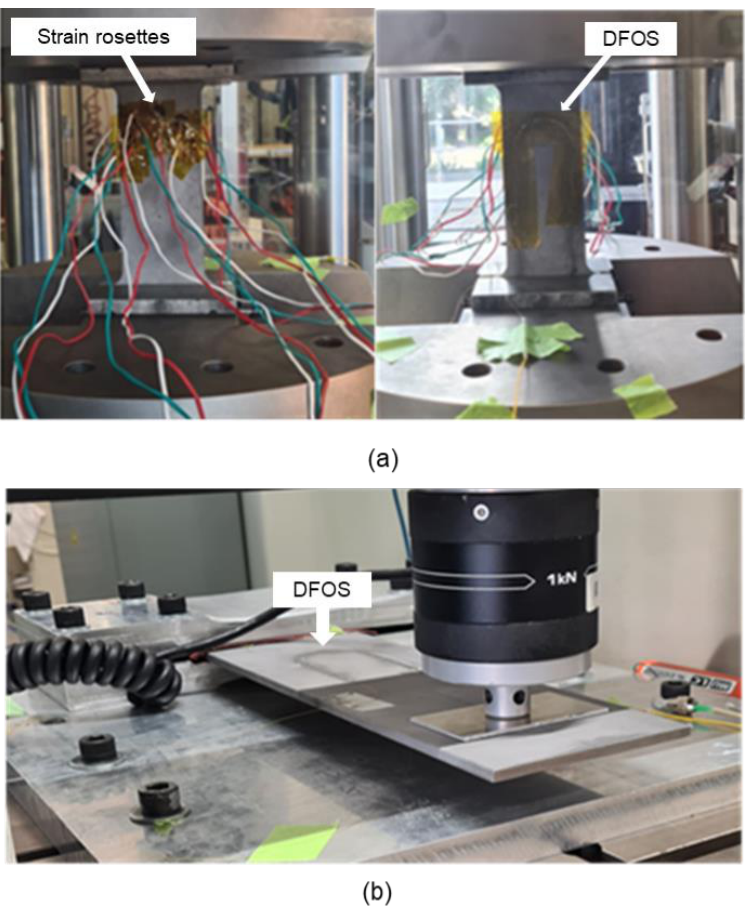
Figure 8. Specimens along with its sensors during testing: ( a ) Tensile loading; ( b ) Flexural loading.